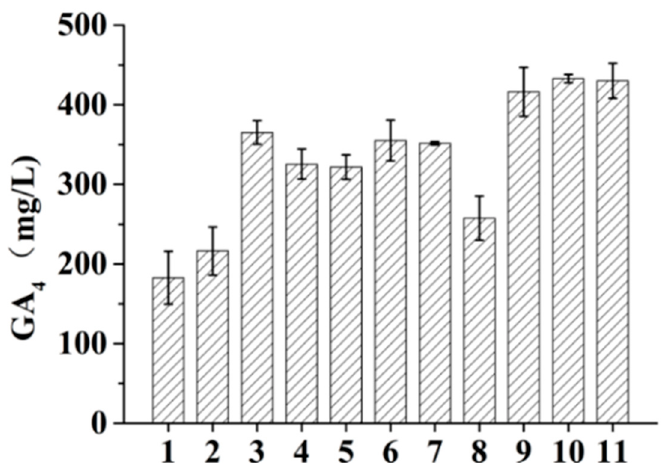
Figure 1. Effect of different vegetable oils on GA4 production by G. fujikuroi QJGA4 ‐ 1.